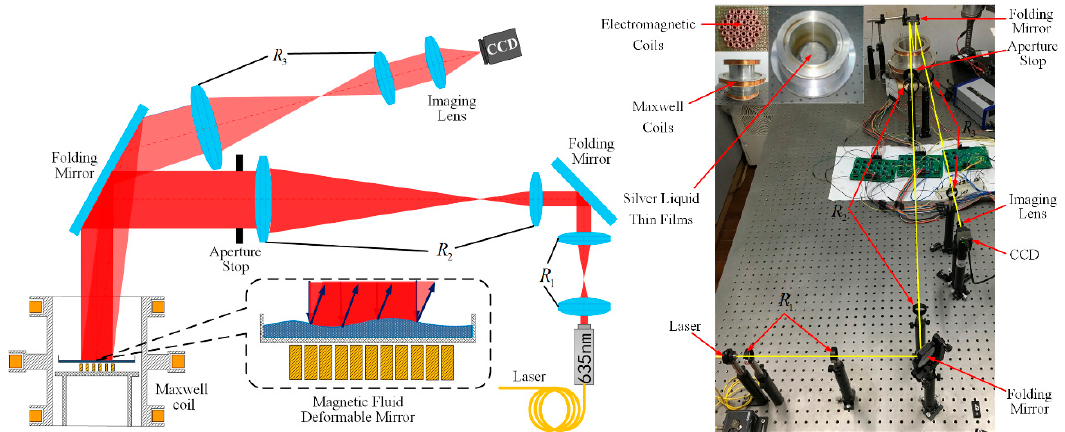
Figure 4. The schematic and actual layout of the experimental setup of wavefront sensorless (WFSless) adaptive optics (AO) system.